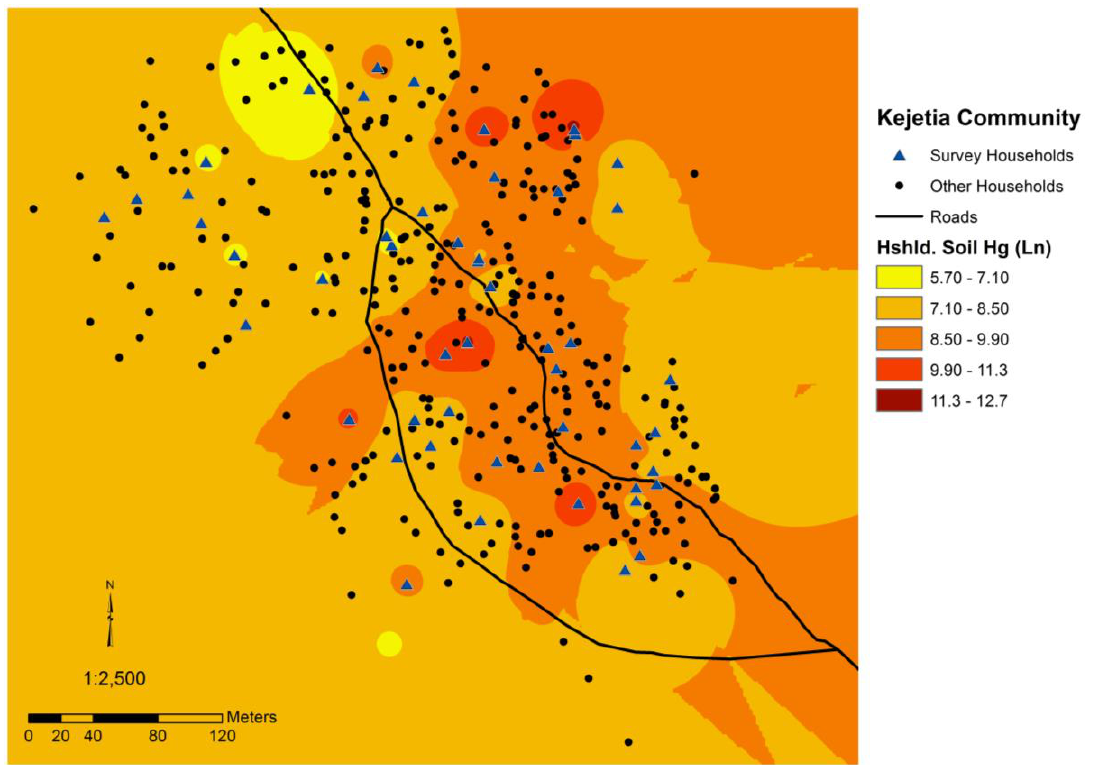
Figure 7. Map of Kejetia including an estimation of mean household soil Hg (log-transformed) throughout the community. Darker red indicates higher estimated household soil Hg